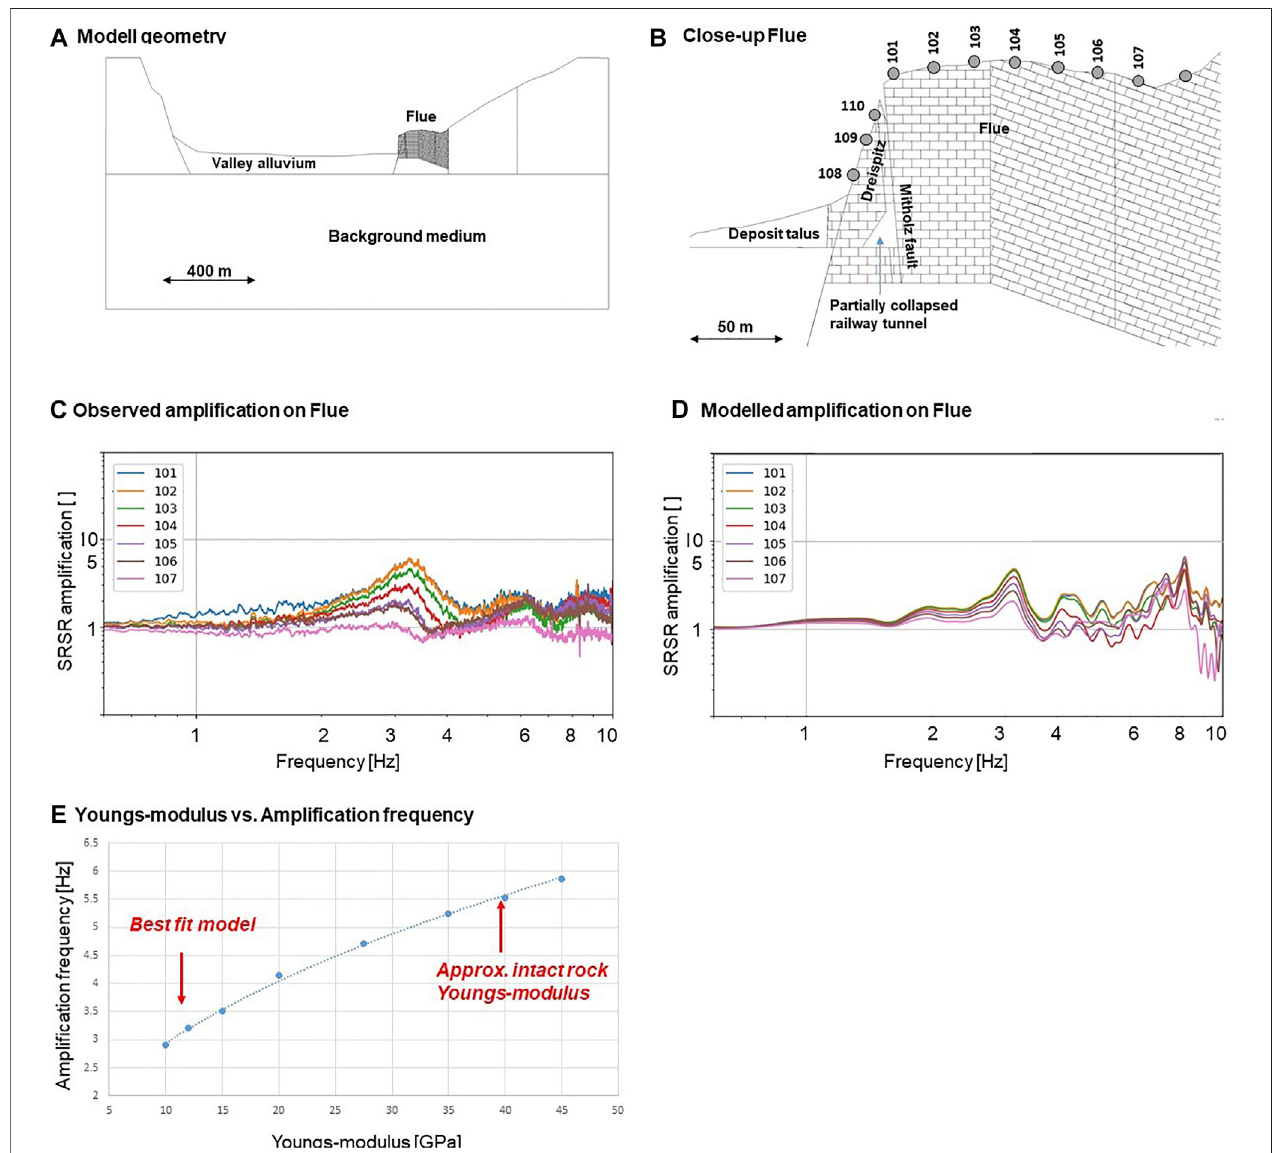
FIGURE 7| Model calibration for the site Mitholz,which exploded uncontrolled in 1947 with (A) the entire model and its boundaries; (B) the geometry ofthe model around Flue ;numbersanddotsarethelocationoftheseismicstations; (C) theobservedampli fi cationvaluesfromthe fi eldmeasurementsofOctober2019,comparedto (D) themodelledampli fi cation values; (E) calibration oftheE-modulusonthe Flue :thebest fi tmodelforanampli fi cationfrequencybetween3.0and3.5 Hzcorresponds to a Young ’ s modulus of 12 GPa.